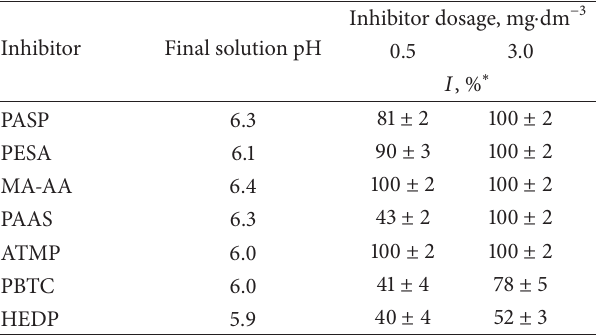
Table 2: Inhibitor relative performance ( 𝐼 , %) in a NACE calcium sulfate supersaturated